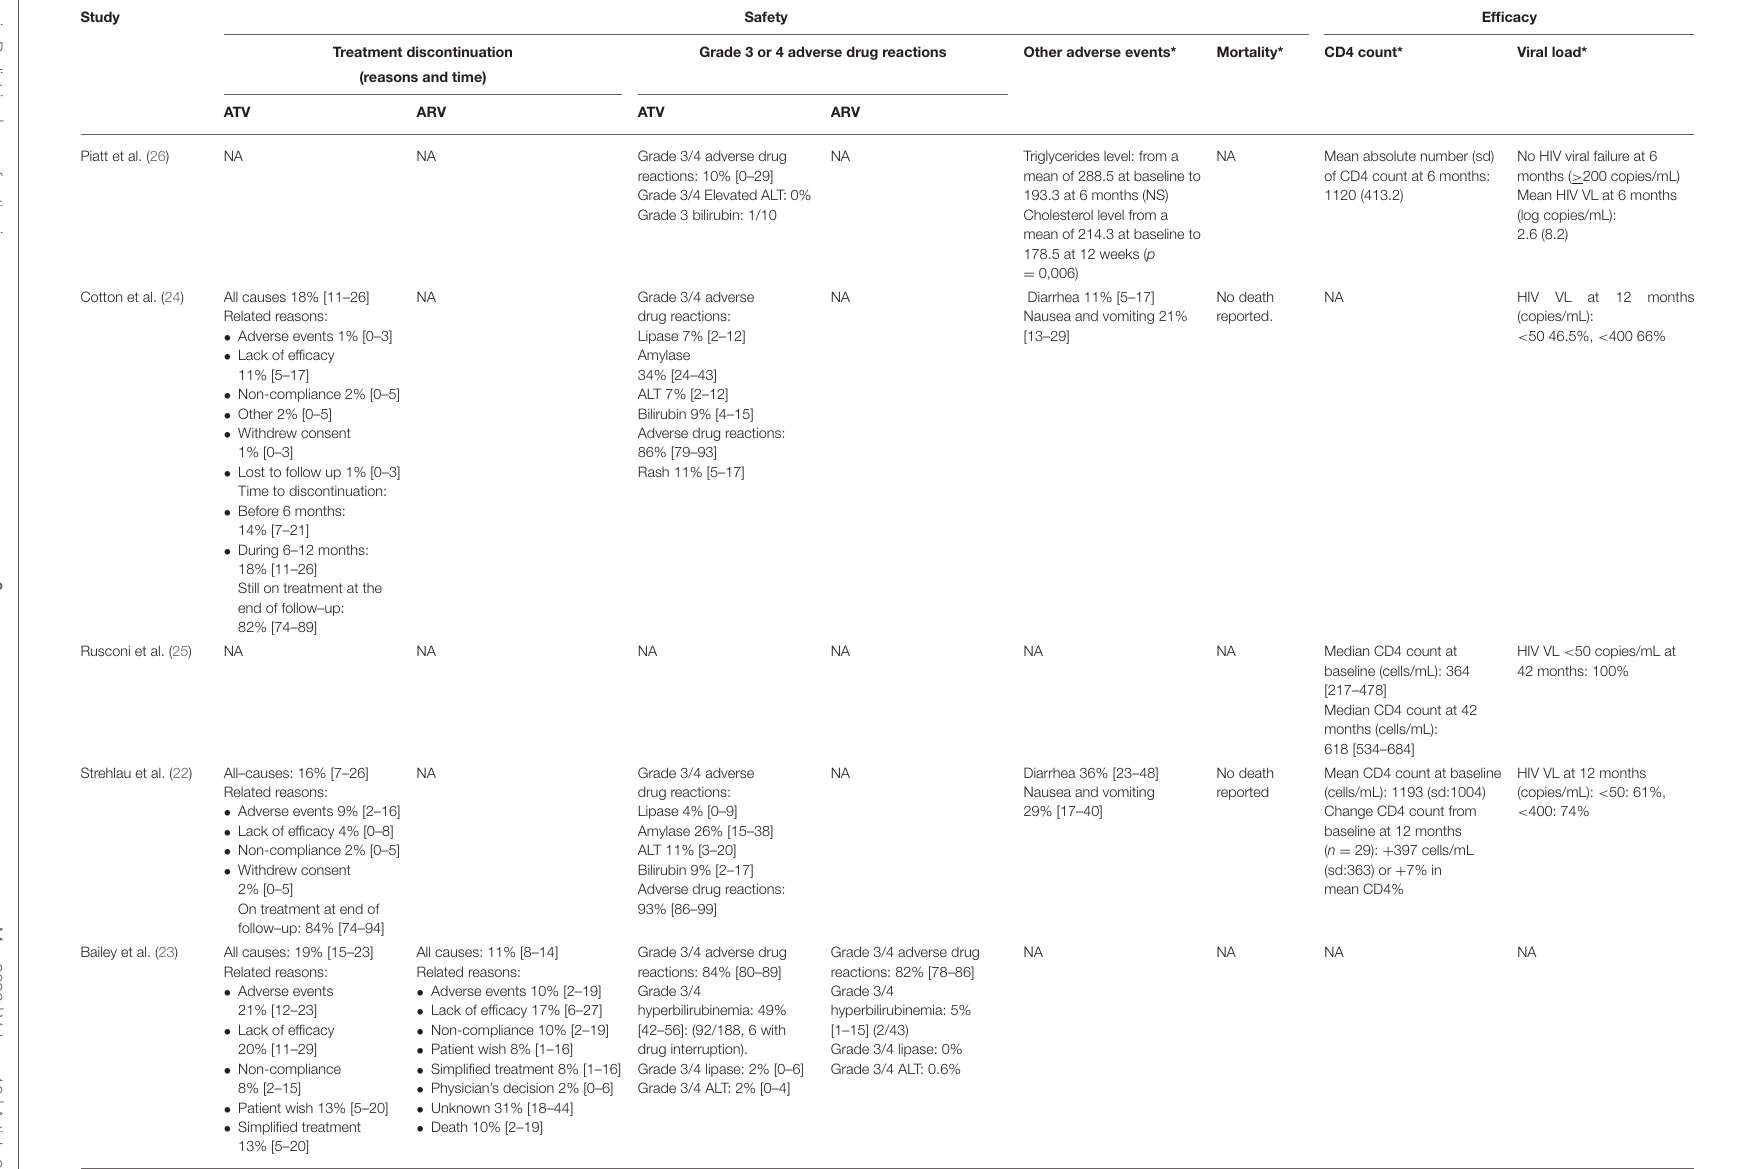
TABLE 2 | Description and summary results for each study included in the systematic review (2009/01/01–2020/10/01).